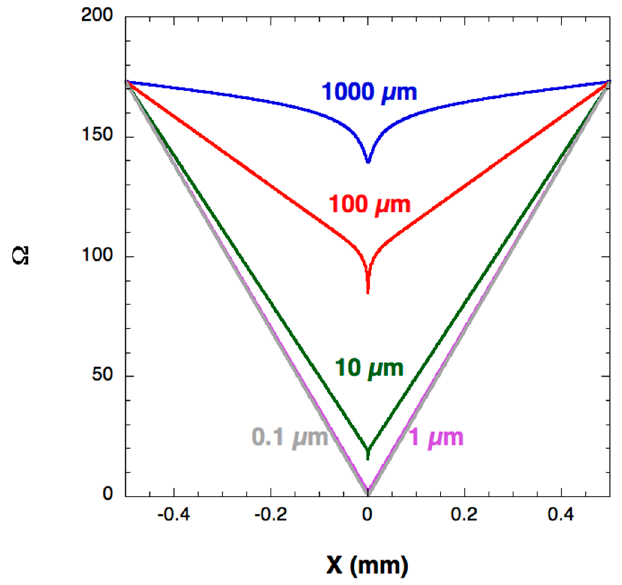
Figure 6. Concentration profiles across the precipitate at x = 0 in the FE simulation for a membrane spacing between 100 nm and 1 mm.